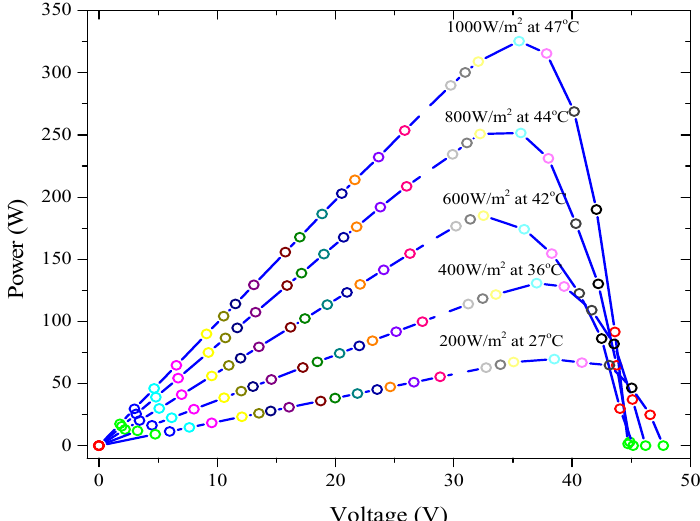
Figure 16. I–V curves of the measured and the calculated currents for the single-diode practical system at different irradiance and temperature levels.